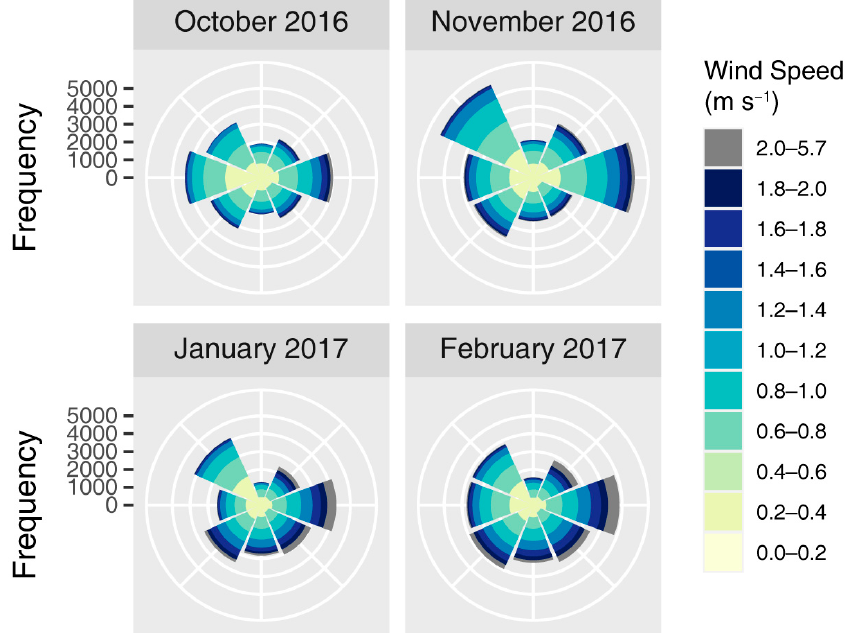
Figure A2. Monthly wind rose plots in the seed dispersal season of 2016–2017. Data in December 2016 was unavailable because of the AWS failure.